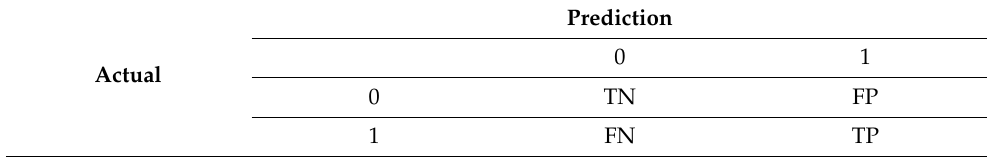
Table 2. Confusion Matrix.